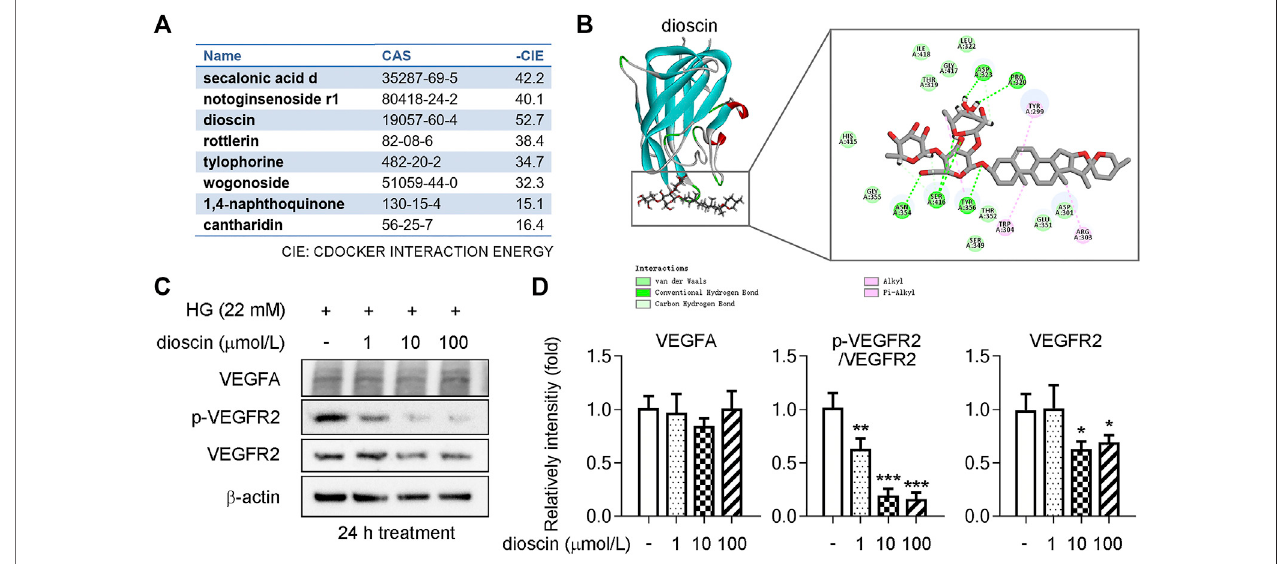
FIGURE 1 | Dioscin inhibits phosphorylation of VEGFR2 in human retinal microvascular endothelial cells. (A) Eight compounds were predicted through the HERB websitetotargetVEGFA,includingCASnumbersand-CIE. (B) InteractionofdioscinwithVEGFAassimulatedbyDSsoftware.Theboxindicatesthe2Dstructureofthe two interactions, the circle indicates the amino acid, and the dashed line indicates the forces that sustain the interaction. (C, D) Protein level of VEGFA and phosphorylationofVEGFR2(p-VEGFR2)andVEGFR2wasdetectedbyWesternblot (C) .QuantitativeresultsofpanelCareshowninpanelD, n (cid:1) 3.* p < 0.05,** p < 0.01, and *** p < 0.001 vs. the control group by one-way ANOVA with Bonferroni